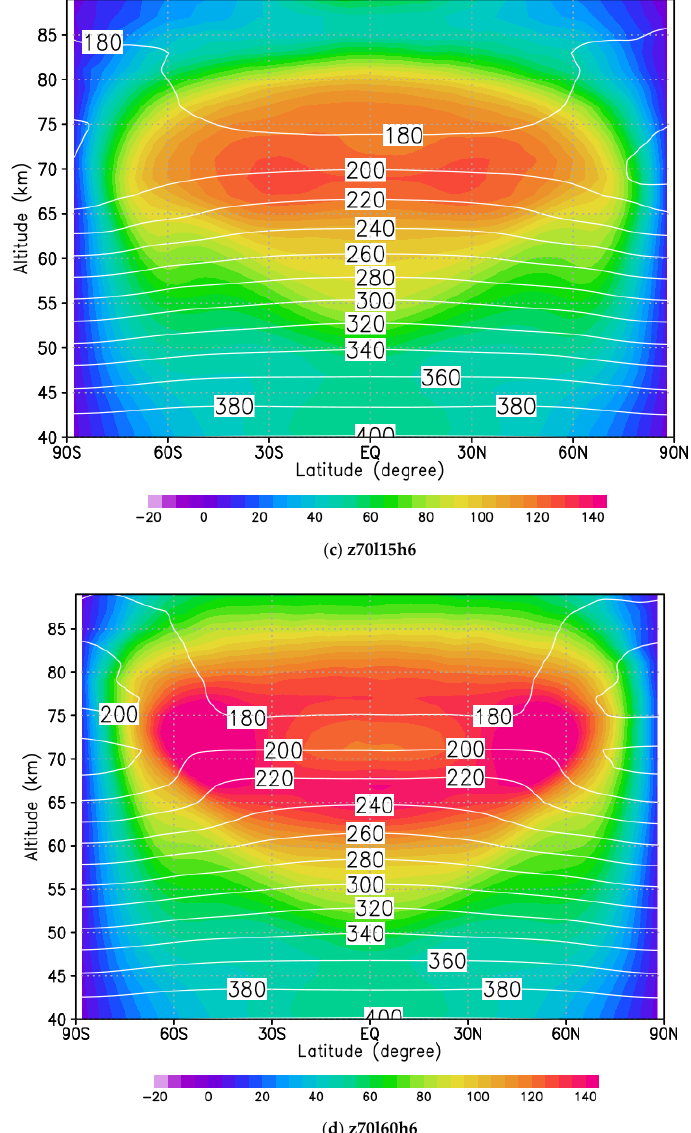
Figure 1. Latitude-altitude cross sections of mean zonal wind (color) and temperature (contour) on 30 January 2005. ( a ) The original CCSR/NIES VGCM [19] observation data, ( b ) free run forecast of AFES-Venus, namely, data is not assimilated, while it is assimilated (analysis) each 6 h at 70 km altitude from 15 ◦ S–15 ◦ N in ( c ) and from 60 ◦ S–60 ◦ N in ( d